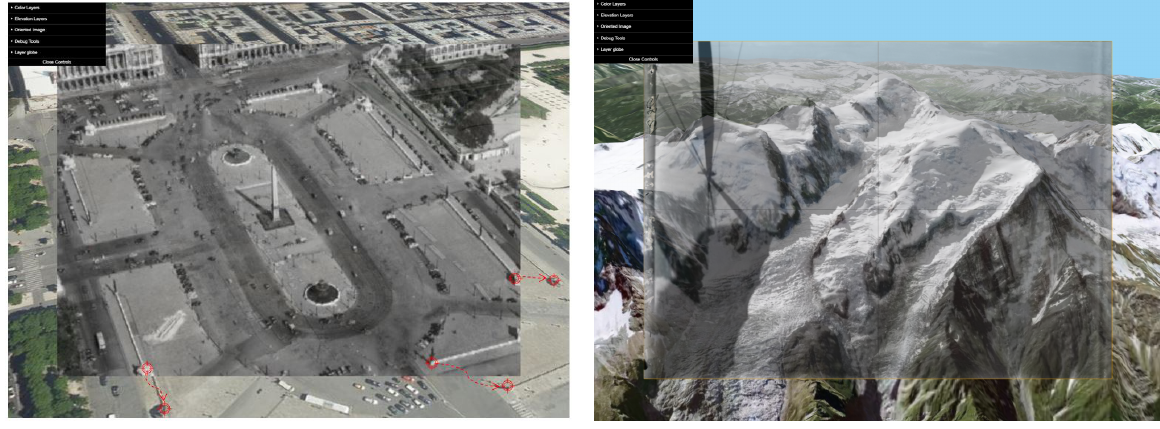
Figure 3. Results on the place Concorde in Paris, France (left) and on the Mont Blanc mountain, France